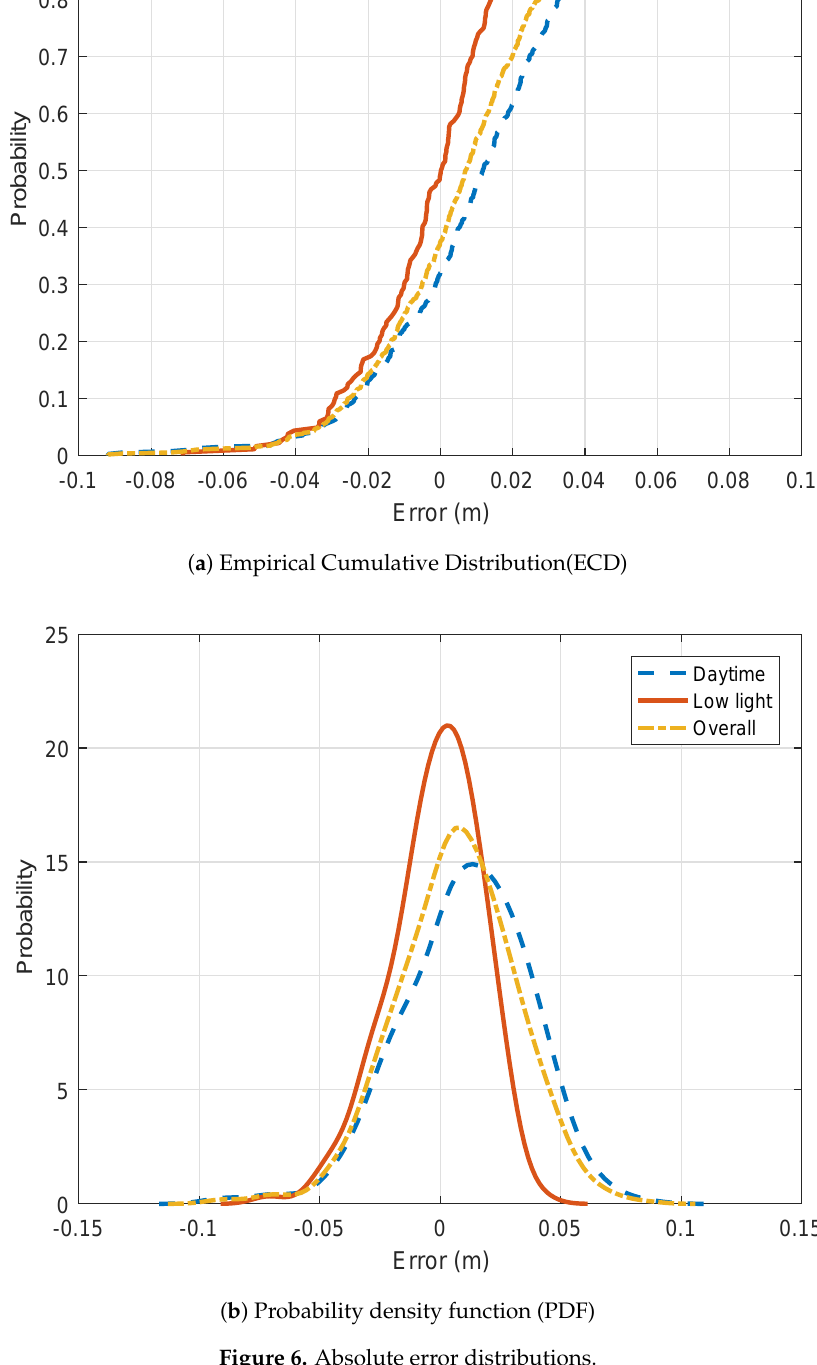
Figure 6. Absolute error